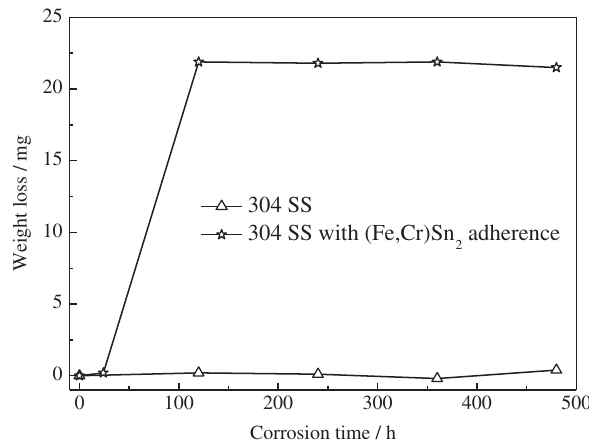
Figure 5: Weight loss of 304 stainless steel after exposure to 300°C water.